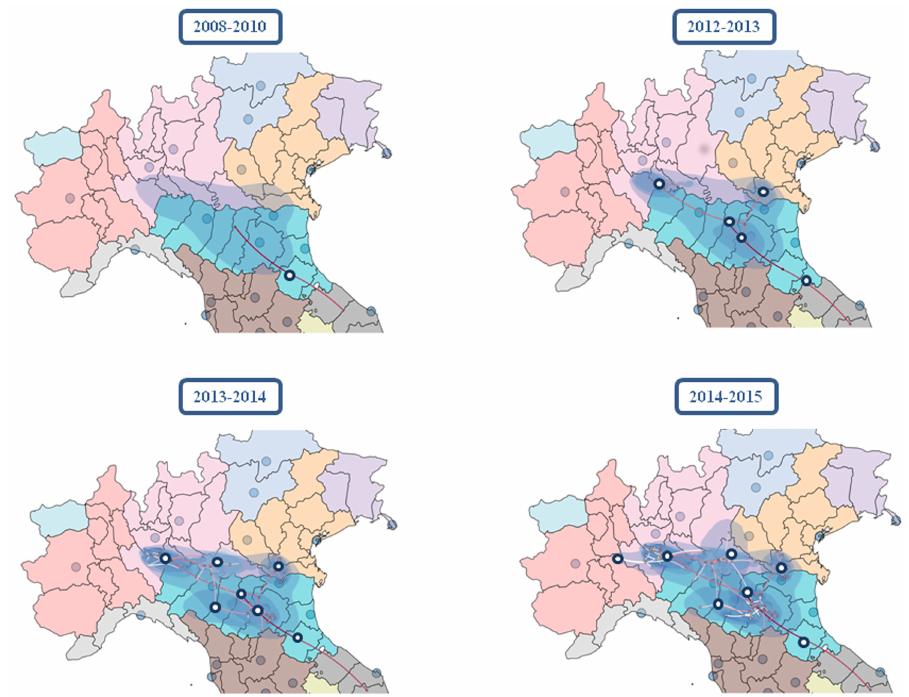
Fig 4. Spatio-temporal dynamics of the West Nile virus epidemic in Italy. The inferred spatiotemporal dynamics of WNV-2 in Northern Italy. The figure summarize the most significantmigrationlinks in the interested area. More detailedresults are reportedin S1